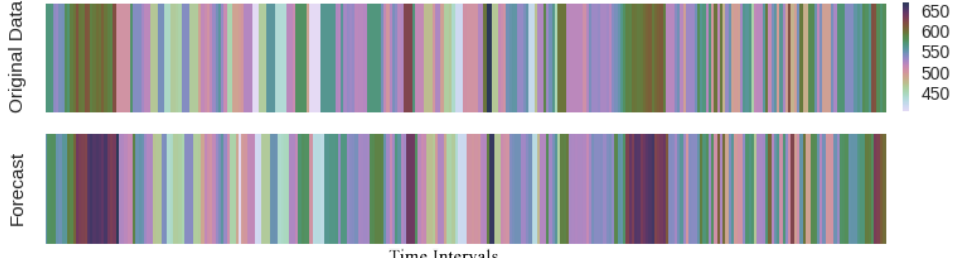
Figure 8. Heat plots of travel-time prediction during 3 days. The horizontal axis is time intervals.